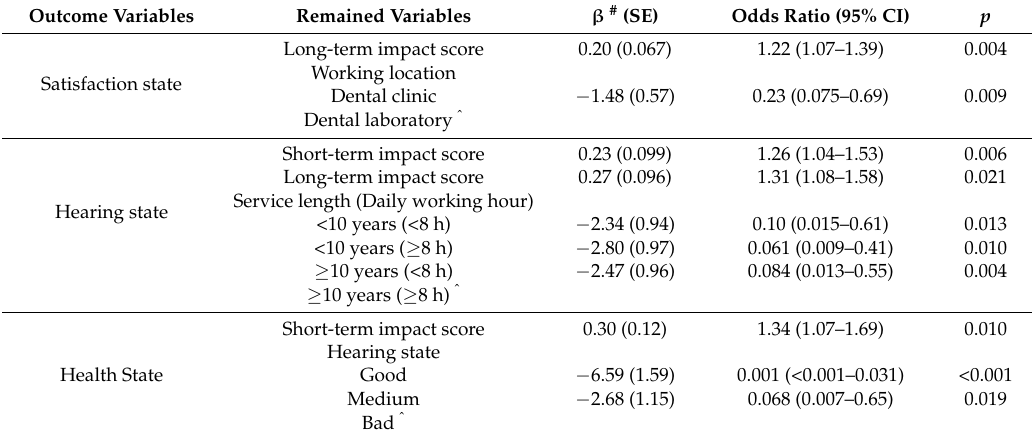
Table 4. Ordinal logistics regressions of the dental professionals’ satisfaction, hearing, health state the other